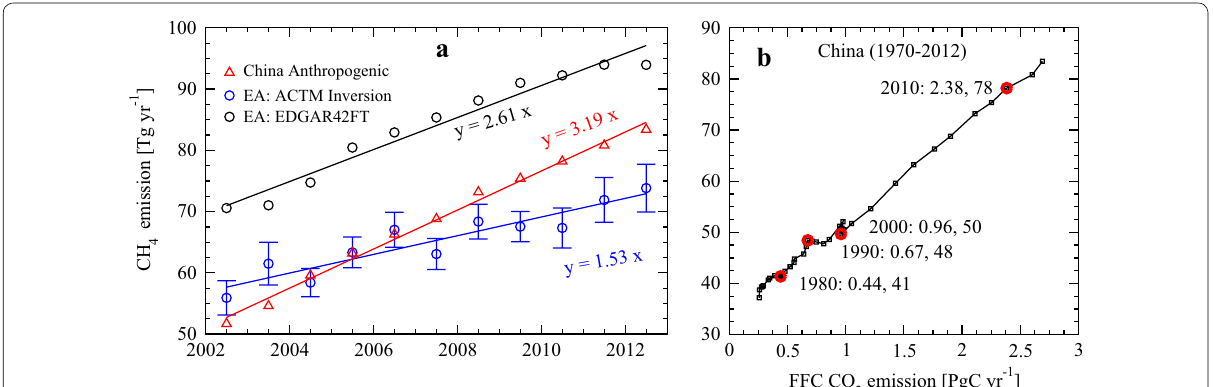
Fig. 2 a Comparisons of CH 4 inversion results ( black : a priori; blue : a posteriori) for the East Asia (EA) region with the EDGAR42FT estimated anthropogenic emissions for China. The linear fits to the annual mean values are shown as lines , with slopes the fits marked. b Linear relationship of anthropogenic CO 2 and CH 4 emissions for China over the period of 1970–2012 (Olivier et al. 2014). The inter-decadal values are marked by text and red